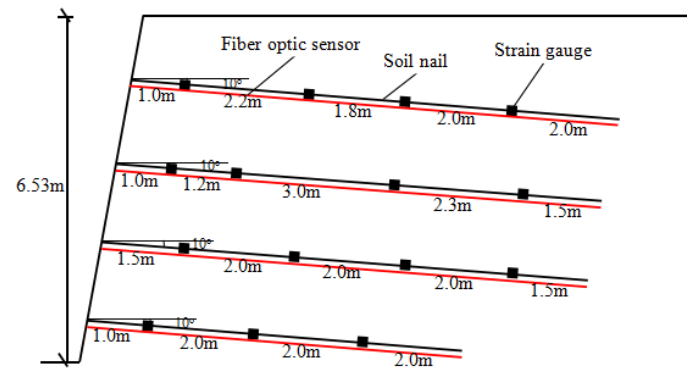
Figure 8. Location of instruments for testing set No. 1.